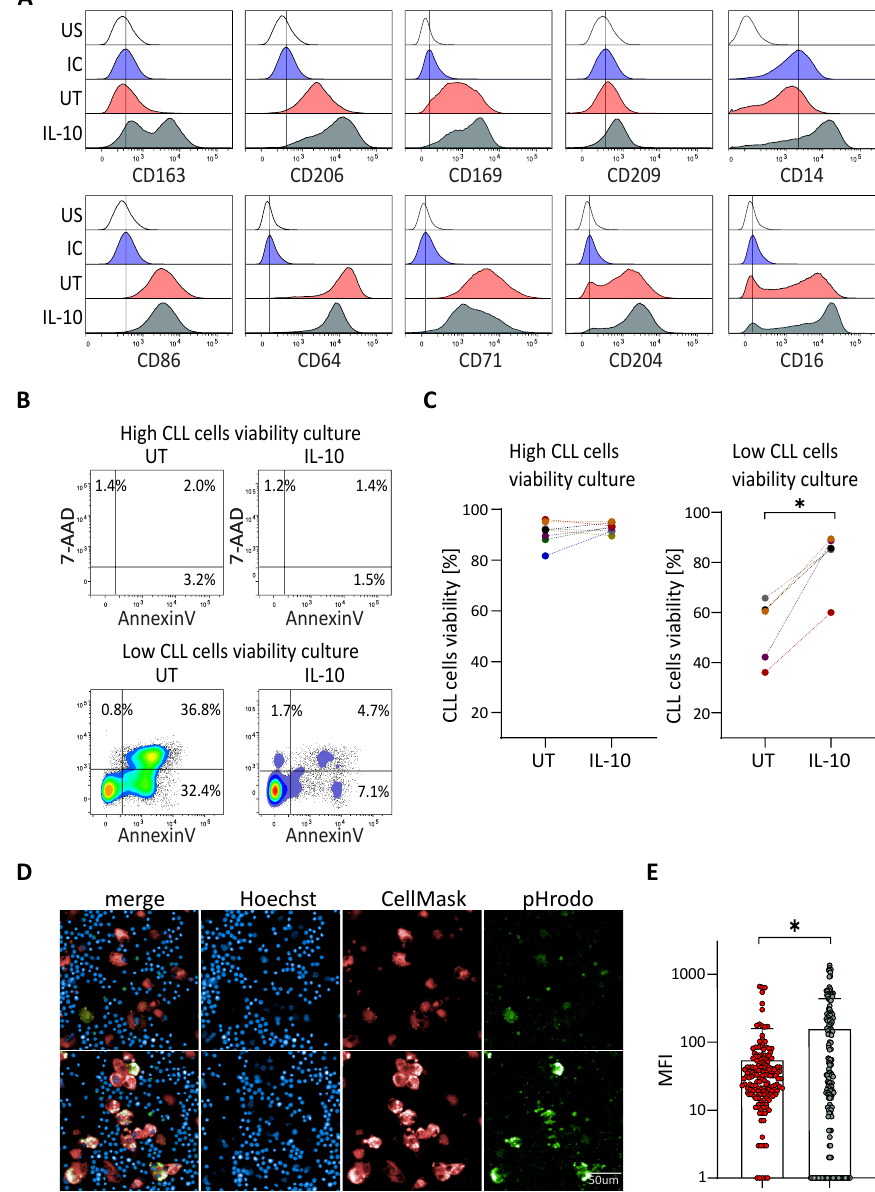
Figure 2. IL-10 rescues viability of CLL cells from patients with low protective NLC. ( A ) Surface markers expressed by NLC analysed by flow cytometry at 14 days of cultures of PBMC from CLL patient with low in vitro CLL cells viability, untreated (UT: red) or treated with IL-10 (grey), comparing to the unstained (US: white) and the isotypic (IC: blue) controls. Representative histograms from five independent experiments. ( B , C ) Percentage of the CLL cells viability at 14 days of culture of PBMC from CLL patient with low or high in vitro CLL cells viability untreated (UT) or treated with